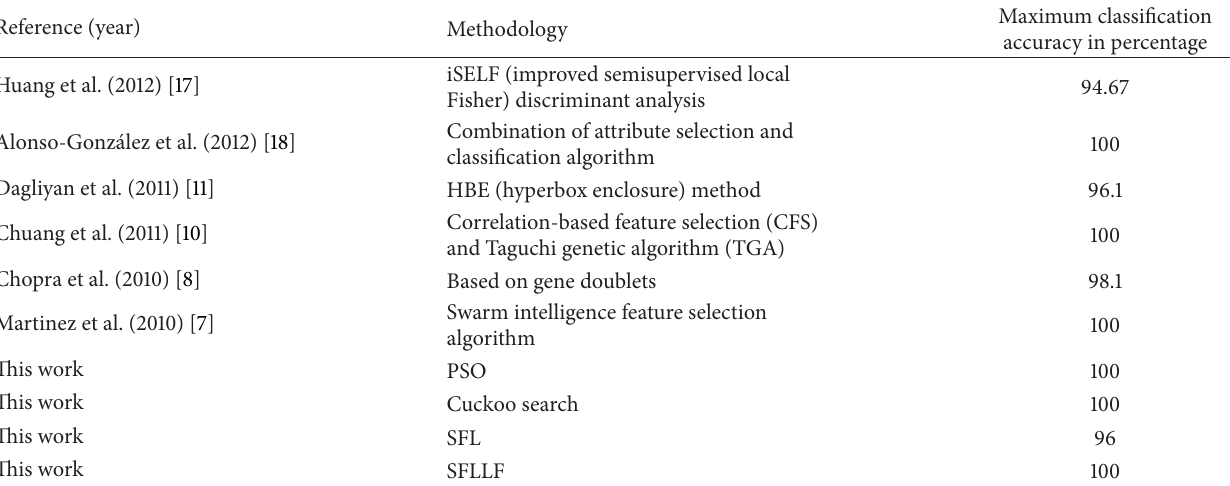
Table 5: Comparison of classification accuracy with other methods for DLBCL